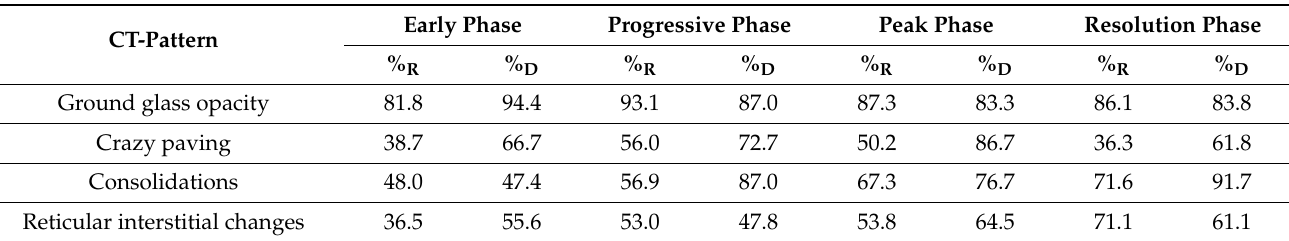
Table 2. Summary of occurrence frequency of CT patterns depending on the disease radiology phase according to our data.